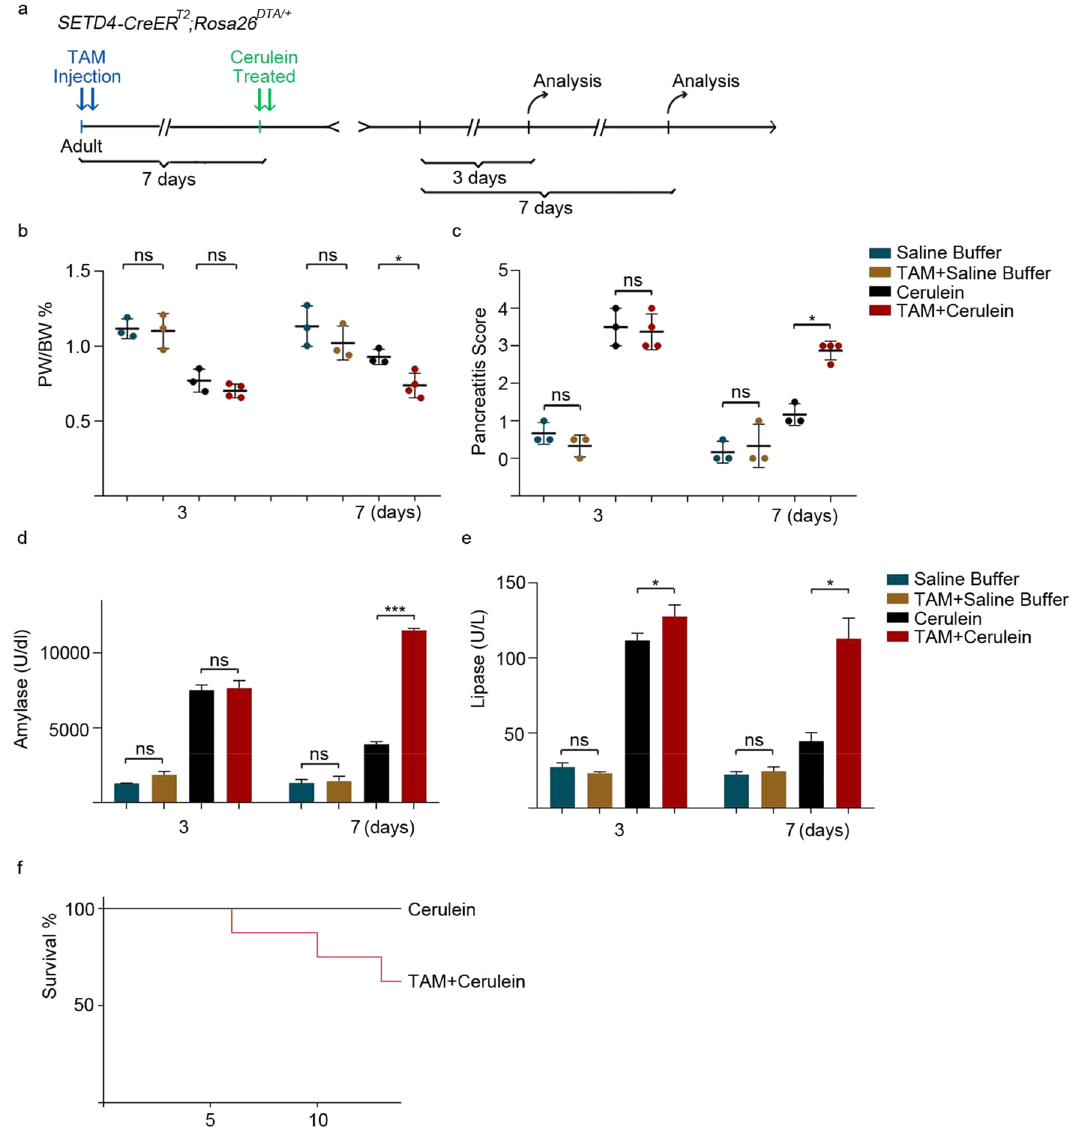
Figure 5. Effects of SETD4 + cells ablation after cerulein-induced injury in adult SETD4-CreER T2 ; Rosa26 DTA/ + mice. ( a ) Experimental outline for SETD4-CreER T2 ; Rosa26 DTA/ + mice. 8–10 week mice were injected with TAM twice over a 24-h period and subjected to an episode of experimental chronic pancreatitis to induced chronic pancreas damage. Mice were sacrificed at two time points: 3 or 7 days after Cerulein treatment. ( b ) Statistics for PW/BW ratio after 3 or 7 days treatments. PW: pancreatic weight, BW: body weight. ( c ) Pancreatitis score after 3 or 7 days treatments. ( d ) and ( e ) Analysis of serum levels of amylase (d) and lipase (e) after 3 or 7 days of treatments. ( f ) survival rates after SETD4 + cell ablation in creulein and TAM + Cerulein mice. Ctrl: Cerulein treatment (n = 3 mice), TAM + Cerulein: cerulein treatment after TAM-induction. (n = 4 mice). All data are represented as mean ± SD. * p < 0.05. ns not